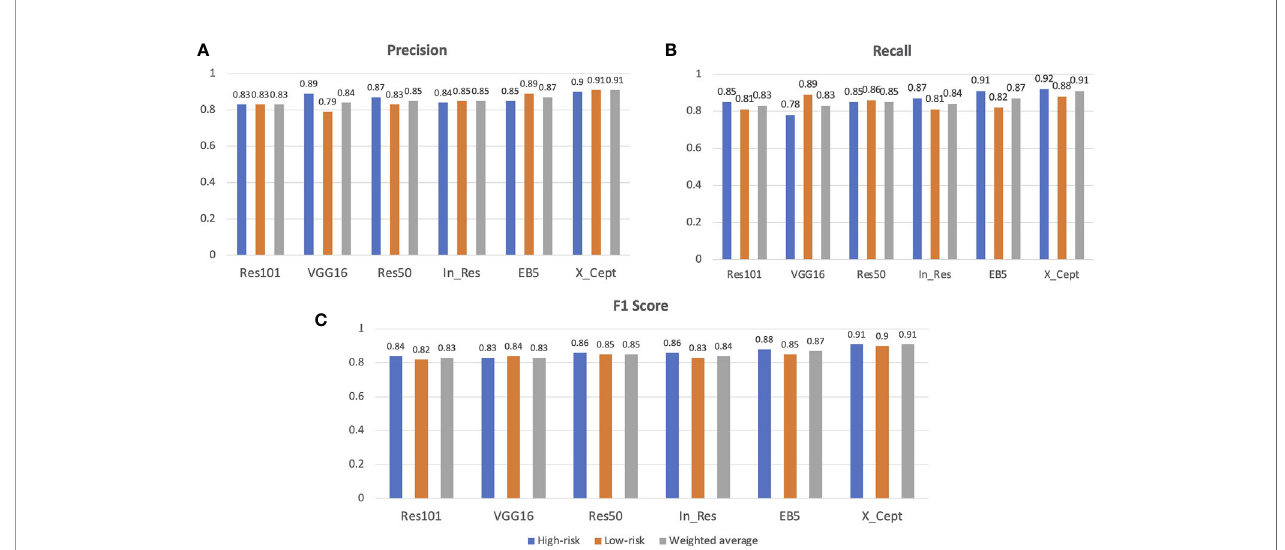
FIGURE 2 | AI model performance evaluation with the validation set. Precision, recall, F1 score and confusion matrix of 6 models, namely VGG16, Res50, Res101, EB5, In_Res, and X_Cept, were used to evaluate model performance along with the accuracy metric. (A) Precision, (B) recall, and (C) F1 score of the 6 models in identifying the high-risk and low-risk groups. The weighted average of precision is also shown.